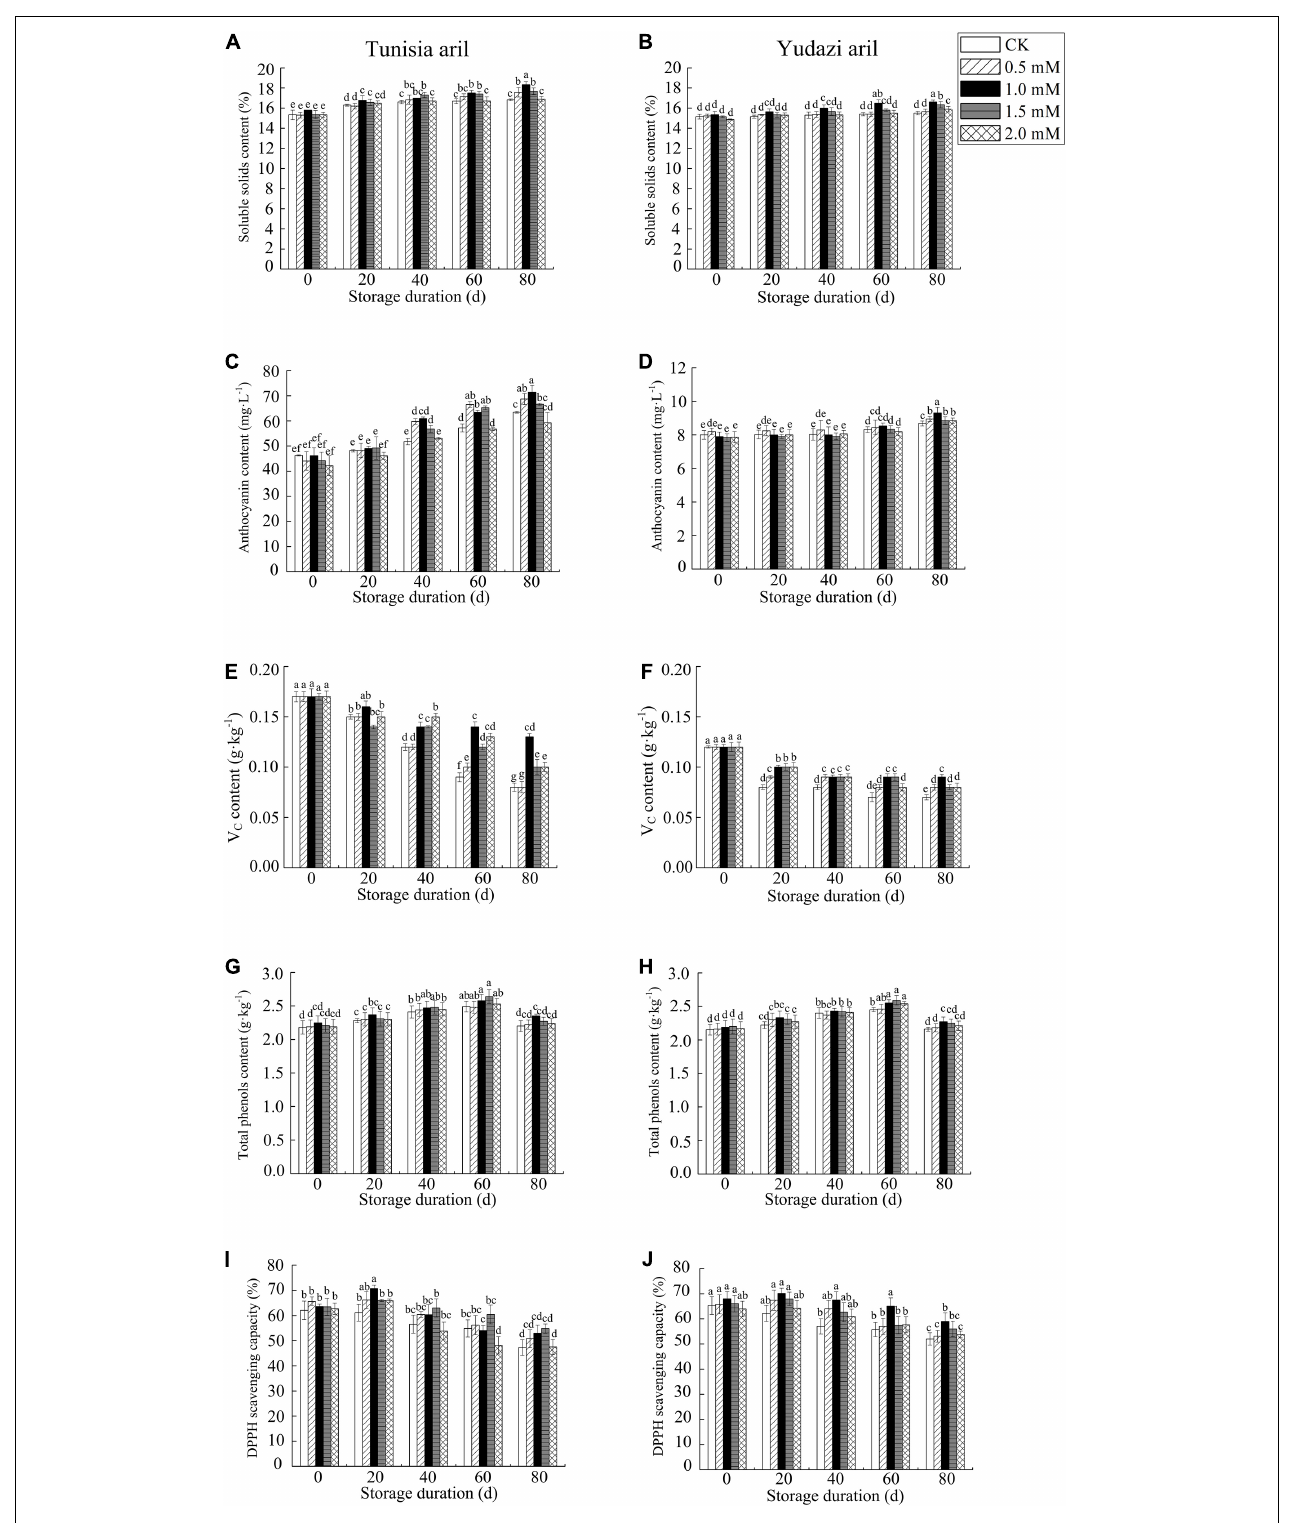
FIGURE 3 | Contents of SSC, anthocyanin, vitamin C, total phenols, and DPPH radical-scavenging capacity in pomegranate arils after arginine treatments during storage at 4 ± 0.5 ◦ C. Panels (A,C,E,G,I) present Tunisia. Panels (B,D,F,H,J) present Yudazi. Values are mean ± standard error of triplicate samples. Different letters showed significant differences among concentration treatments and sampling dates during the cold storage at P < 0.05. SSC, soluble solids content; DPPH, 2,2-diphenyl-1-picrylhydrazyl.